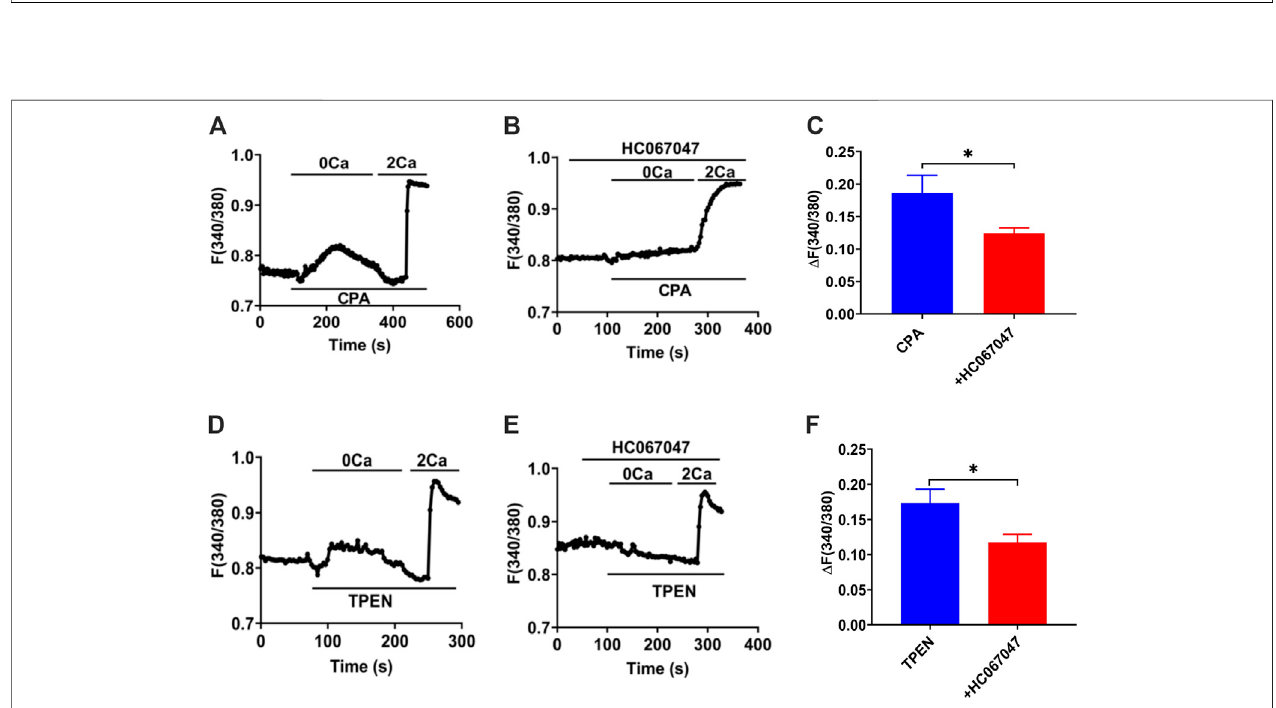
FIGURE 12 | TRPV4-constituted SOCE mechanism in IECs. (A) Time courses of CPA (10 μ M)-induced Ca 2+ signaling in the extracellular Ca 2+ omission (0 Ca, left) or not (2 Ca, right) in ICE-6 cells. (B) Time courses of CPA-evoked Ca 2+ signaling with HC067047 (30 μ M) pretreated in extracellular Ca 2+ omission or not. (C) CPA- induced [Ca 2+ ] cyt mobilization with HC067047 (30 μ M) pretreated in HEC-6 cells superfused with Ca 2+ - containing solution (2 Ca). Results are presented as mean SE ( n (cid:2) 25 – 35 cells). (D) TPEN (50 μ M) -evoked Ca 2+ signaling in the extracellular Ca 2+ omission (0 Ca, left) or not (2 Ca, right) in ICE-6 cells. (E) TPEN-evoked Ca 2+ signaling with HC067047 (30 μ M) pretreated in extracellular Ca 2+ omission or not. (F) TPEN-induced [Ca 2+ ] cyt mobilization with HC067047 (30 μ M) pretreated inHEC-6 cells superfused with Ca 2+ - containing solution (2 Ca). Results are presented as mean SE ( n (cid:2) 25 – 35 cells) * p < 0.05 vs. corresponding control by Student ’ s unpaired, two-tailed